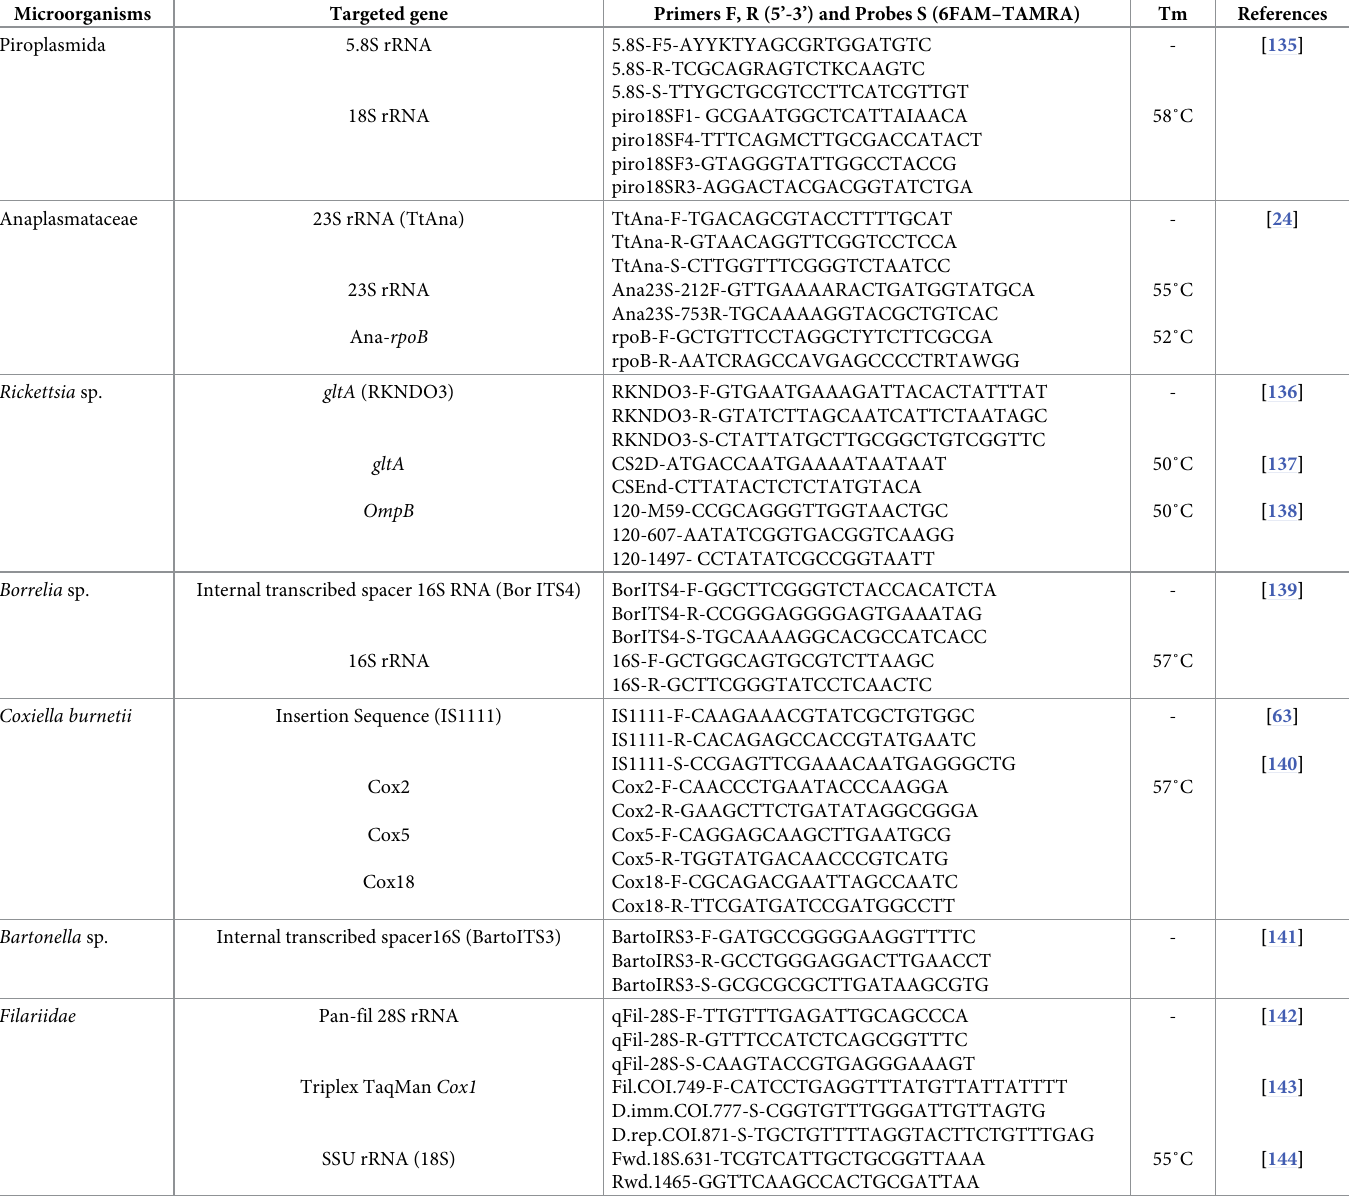
Table 2. Primers and probes used for qPCR, Standard PCR and sequencing in this study.